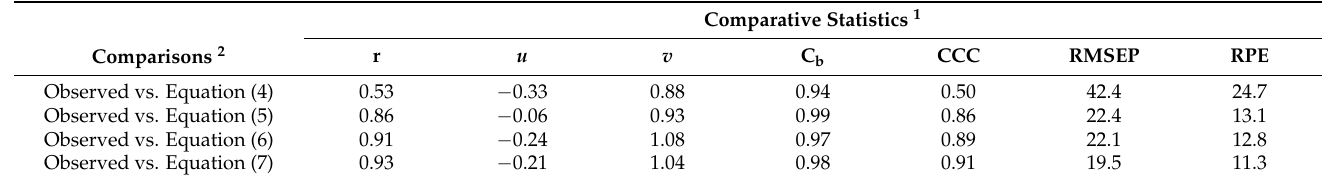
Figure 2. Predicted urinary nitrogen (UN) excretion (g/d) compared with actual UN excretion. Predicted values were calculated using newly developed equations: Equation (4): UN = 0.0214 × MUN × BW for total mixed ration (TMR) and UN = 0.0240 × MUN × BW for Pasture fed cows; Equation (5): UN = − 209.4 + 6.8 × MUN + 12.4 × CP + 4.8 × DMI; Equation (6): UN = − 281.3 + 6.7 × MUN + 13.2 × CP + 2.8 × DMI + 0.16 × BW; Equation (7): UN = ( − 0.253 + 0.00932 × MUN + 0.0260 × CP) × BW.